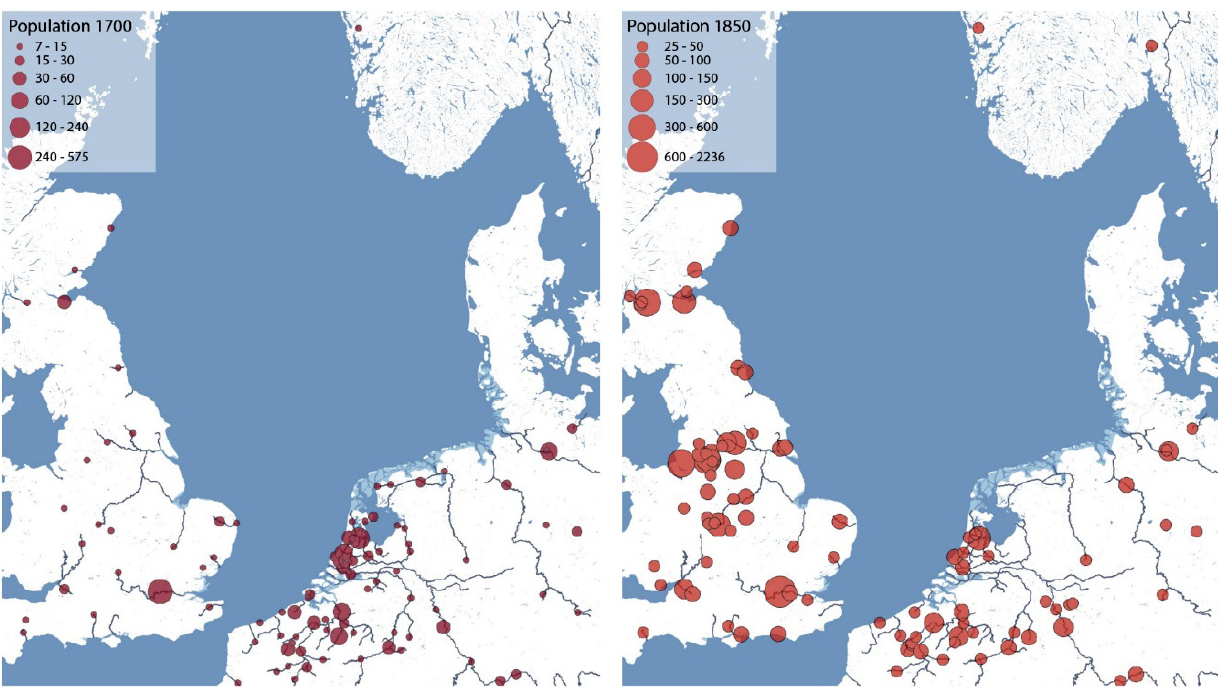
Figure 7. Cities around the North Sea area with the largest populations in 1700 and 1850, combined with main water courses. Map by Yvonne van Mil. Source: van Mil and Rutte (2020a,